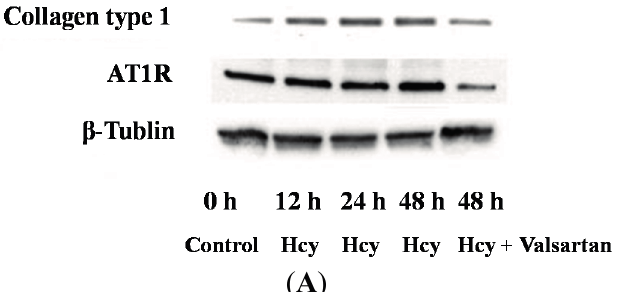
Figure 3. Effect of homocysteine on the expression of collagen type 1 and AT 1 R in cultured adventitial fibroblasts. ( A ) Western blot indicated collagen type 1 and AT 1 R levels in cells treated with L -Hcy (100 µmol/L) for different periods of time, or pretreated with valsartan (100 nmol/L) for 30 min followed by L -Hcy (100 µmol/L) treatment for 48 h ( n = 4). Densitometric analyses of collagen type 1 and AT 1 R were performed against β -tubulin. * p < 0.05 compared with controls ( B , C